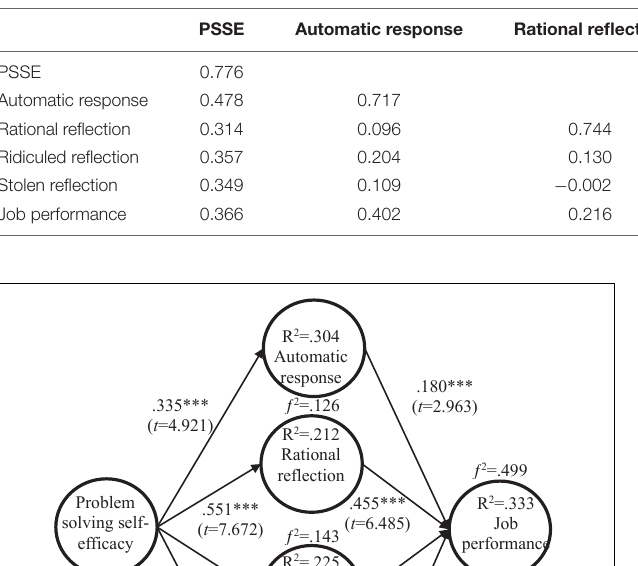
TABLE 3 | Construct discriminative validity analysis.